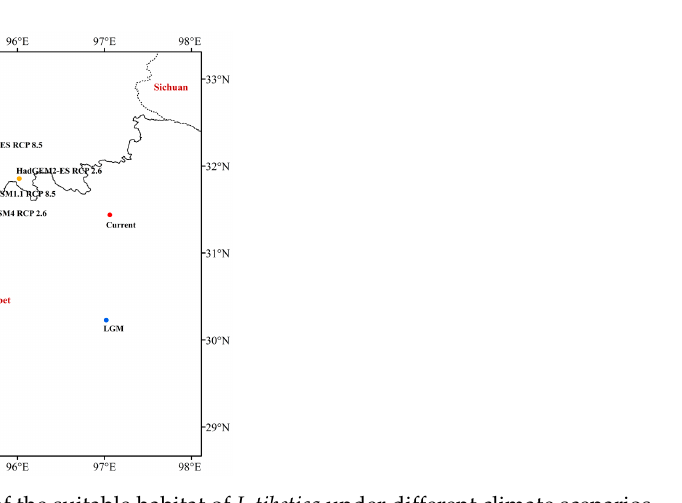
Figure 8. The centroid of the suitable habitat of J. tibetica under different climate scenarios.